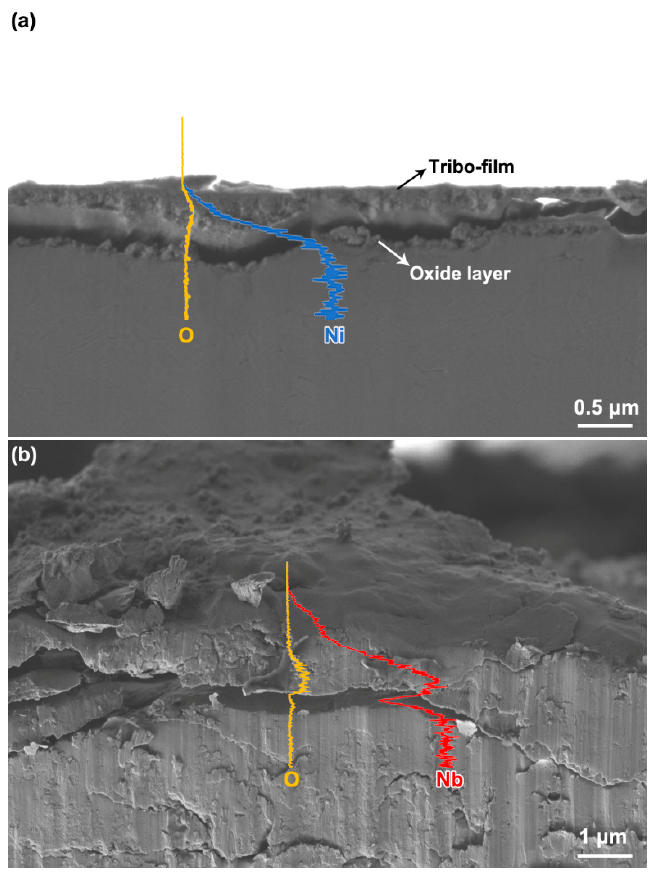
Figure 8. The SEM images and EDS lining scans of the cross-sections of the wear tracks from the potentiostatic tribocorrosion tests (400 mV): ( a ) Ni and ( b ) Nb.